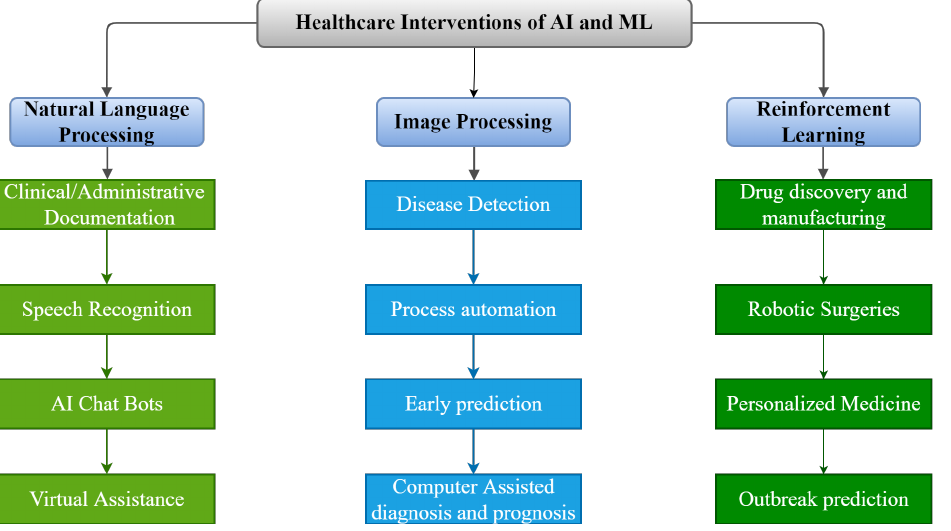
Figure 2. Applications of AI and ML in Medical